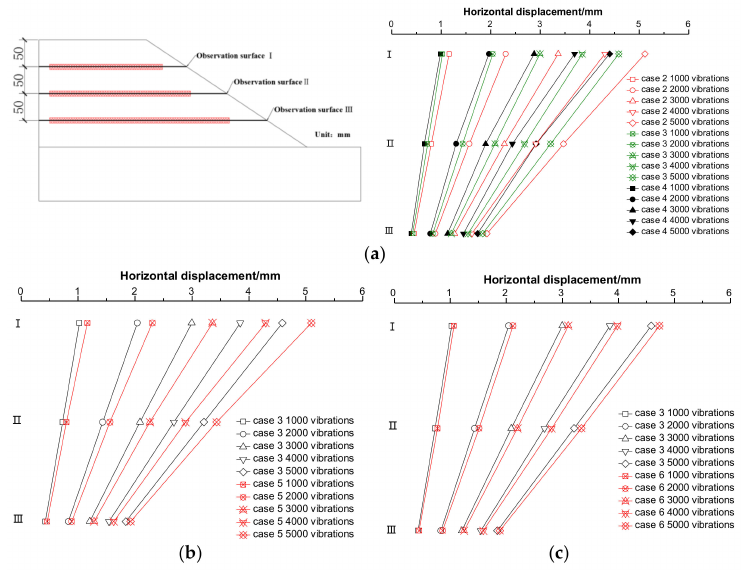
Figure 8. Horizontal displacement of slope changing with vibration times under cyclic loading under different conditions. ( a ) different reinforcement layers; ( b ) different geocell heights; ( c ) different welding